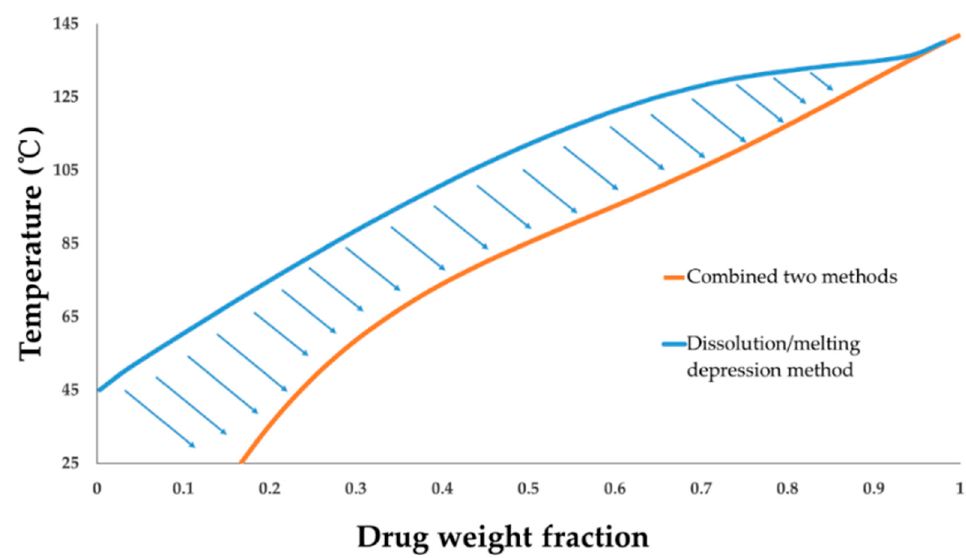
( Φ ) from dissolution / melting depression ∗ (Φ 1 , T 12 (cid:2869) , T) from dissolution/melting depression (cid:2869)(cid:2870)